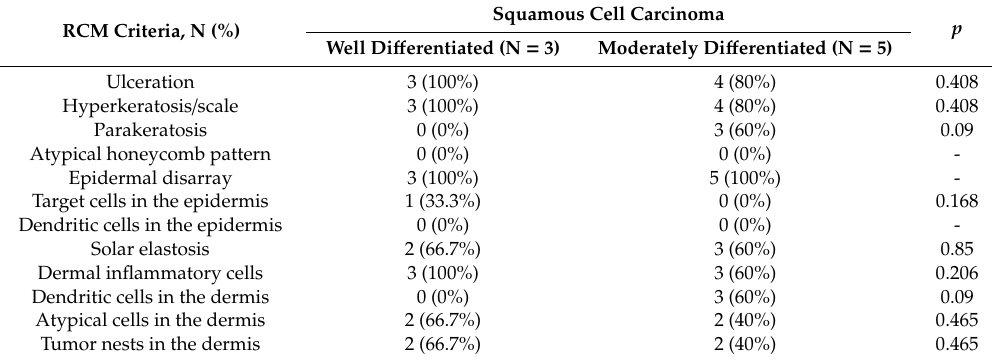
Table 4. Frequencies of RCM criteria according to SCC degree of di ff